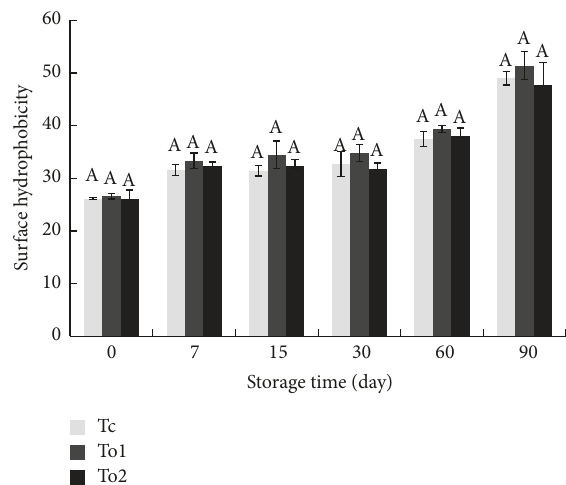
Figure 2: Changes in Ca 2+ -ATPase activity of myofibrillar proteins extracted from silver carp surimi during frozen storage. Light grey: two washing cycles using ice water only (Tc), dark grey: first and second washing cycle using ice water containing 8 mg/L ozone and ice water, respectively (To1); black: first and second washing cycle using ice water and ice water containing 8 mg/L ozone, respectively (To2).Differentlettersindicatesignificantdifferenceamongsamples (Tc, To1, and To2).